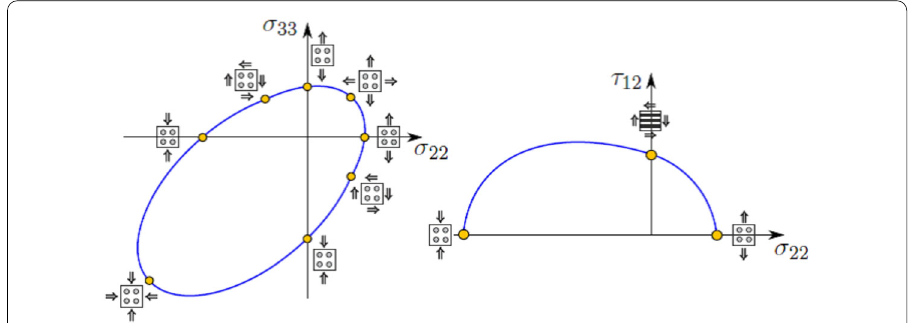
Fig. 5 Schematic representation of the yield surface for UD composites in stress